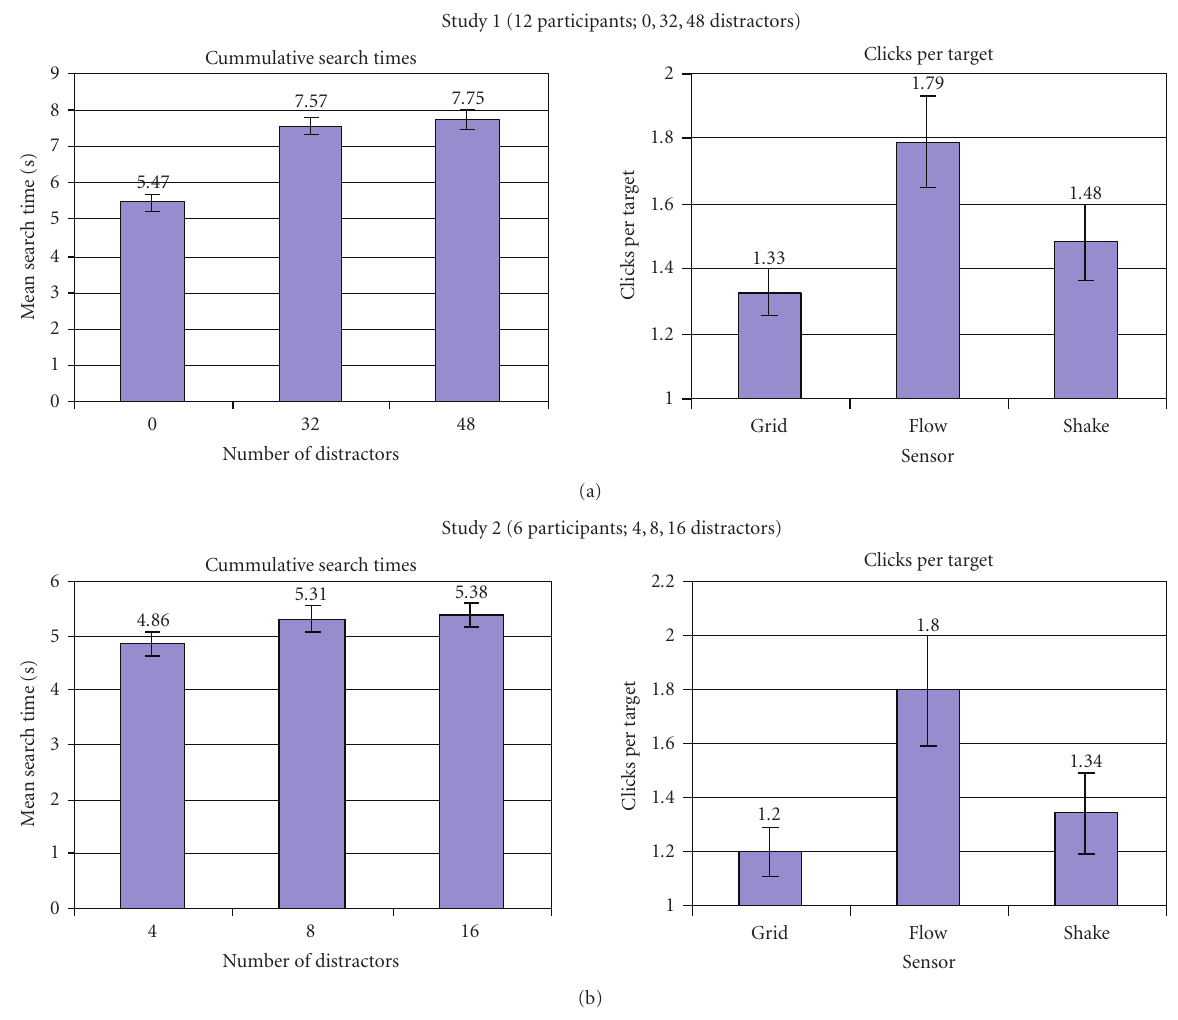
Figure 5: Overall task time by number of distractors (left) and mean number of clicks per target (right).